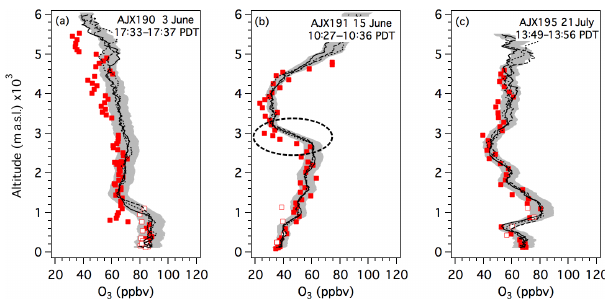
Figure 13. Profile plots comparing the TOPAZ (black lines) and 10s AJAX (red squares) measurements on (a) AJX190, 3 June; (b) AJX191, 15 June; and (c) AJX195, 21 July. The closed squares correspond to the Alpha Jet descent and the open squares the subse- quent climb out. Note the differences between these measurements. The dotted, dashed, and solid lines show the order of the three 8min lidar profiles that bracket the AJAX profile. The gray envelopes show the mean lidar profile ± 10% as reference. The significance of the dashed oval in (b) is discussed in the text.